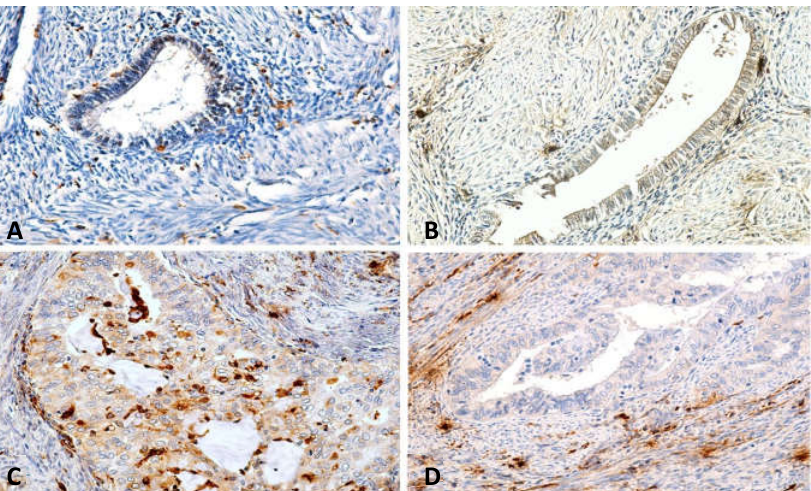
Figure 8. ( A – D )—Presence of macrophages and mast cells in the area adjacent to endometriotic foci. ( A ) Endometriosis of the abdominal wall. Immunolabeled CD68 + macrophages (brown marking) are observed in the periglandular stroma; ( B ) hyperplastic transformed adenomyosis, with atypical cellularity. Immunolabeled CD68 + macrophages (brown marking) present in the glandular epithelium, periglandular. Immunostaining with anti-CD68 antibody, [ × 200]; ( C ) adenomyosis— Tryptase + mast cells, immunolabeled (brown marking), in the periglandular stroma; ( D ) hyperplastic transformed adenomyosis, with atypical cellularity. Tryptase + mast cells are immunolabeled (brown marking) in the periglandular stroma. Immunostaining with anti-tryptase antibody, [ × 200]. CD68: Cluster of differentiation